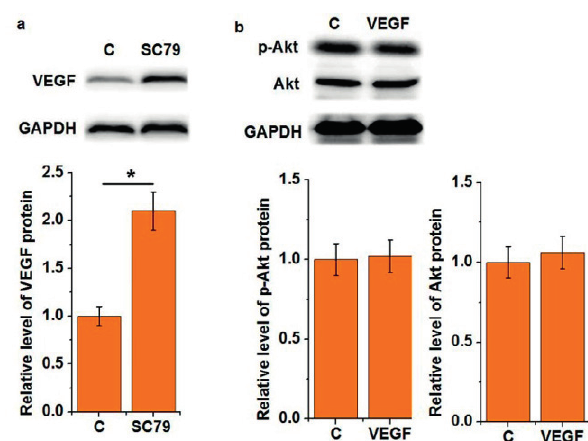
Fig. 3. Comparison of survival curves of patients with high and low serum level of CIP2A.